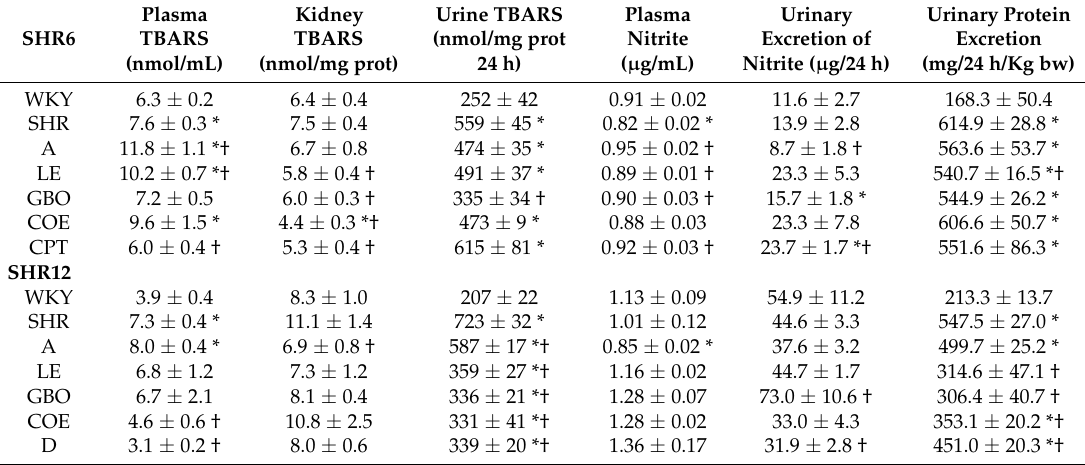
Table 5. Measurements of thiobarbituric acid reactive substances (TBARS), nitrite, and proteinuria in the experimental